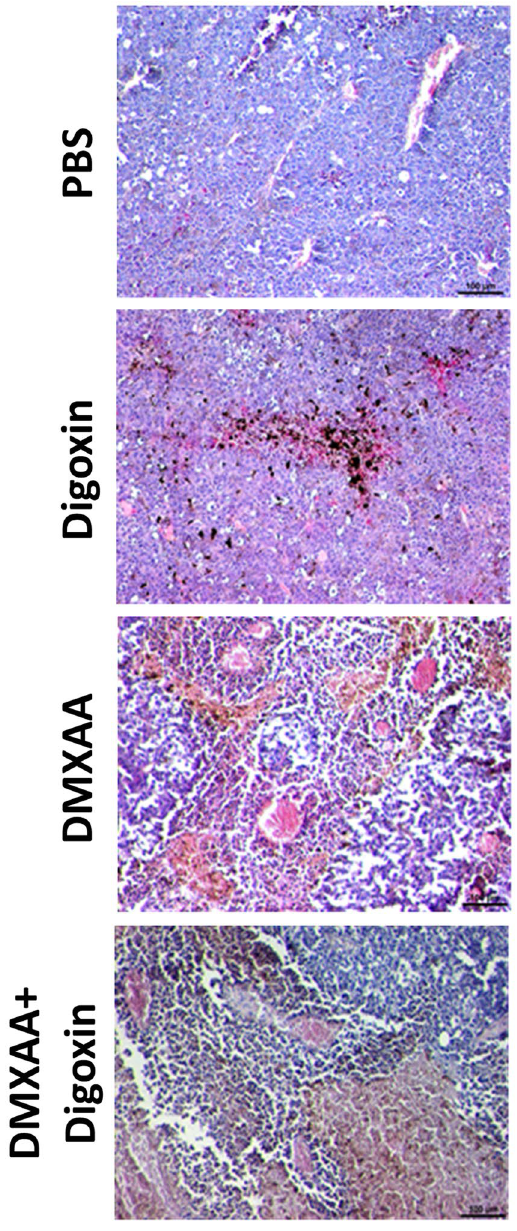
Figure 2. Hematoxylin and eosin staining after administration of DMXAA and digoxin. After administration of DMXAA and combined therapy destroyed blood vessels and infiltration of immune cells in the tumors were observed. Digoxin was shown to reduce the area of necrosis in tumors. Lens magnification 10 ×